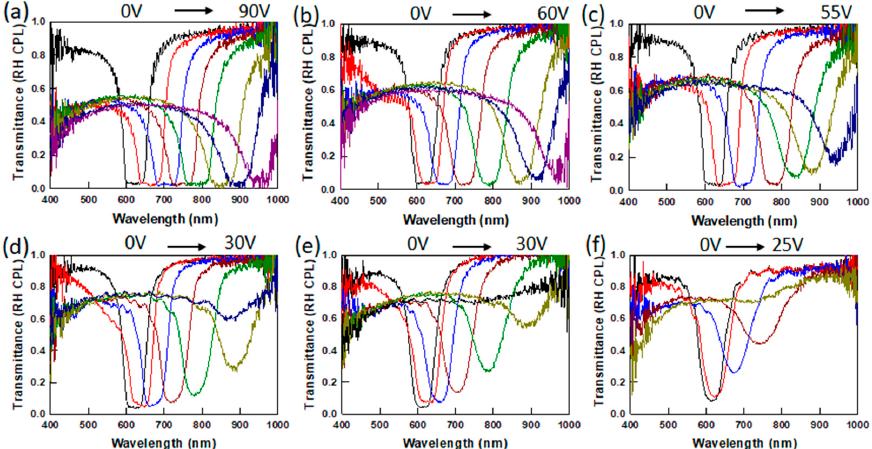
Figure 10. Transmission spectra of negative ∆ε PSCLCs with various cell thicknesses and DC voltages in the ranges shown above each graph: ( a ) 14.1 ± 0.3 µm thickness, 0 V to 90 V DC, ( b ) 10.3 ± 0.3 µm, 0 V to 60 V DC, ( c ) 7.6 ± 0.2 µm, 0 V to 55 V DC, ( d ) 4.9 ± 0.2 µm, 0 V to 30 V DC, ( e ) 3.6 ± 0.2 µm, 0 V to 30 V DC and ( f ) 2.5 ± 0.2 µm, 0 V to 25 V DC. Composition: 0.4 wt.% I-369, 6 wt.% SL04151, 5 wt.% R1011, 4 wt.% R811, and 84.6 wt.% MCL 2079. Adapted from ref.